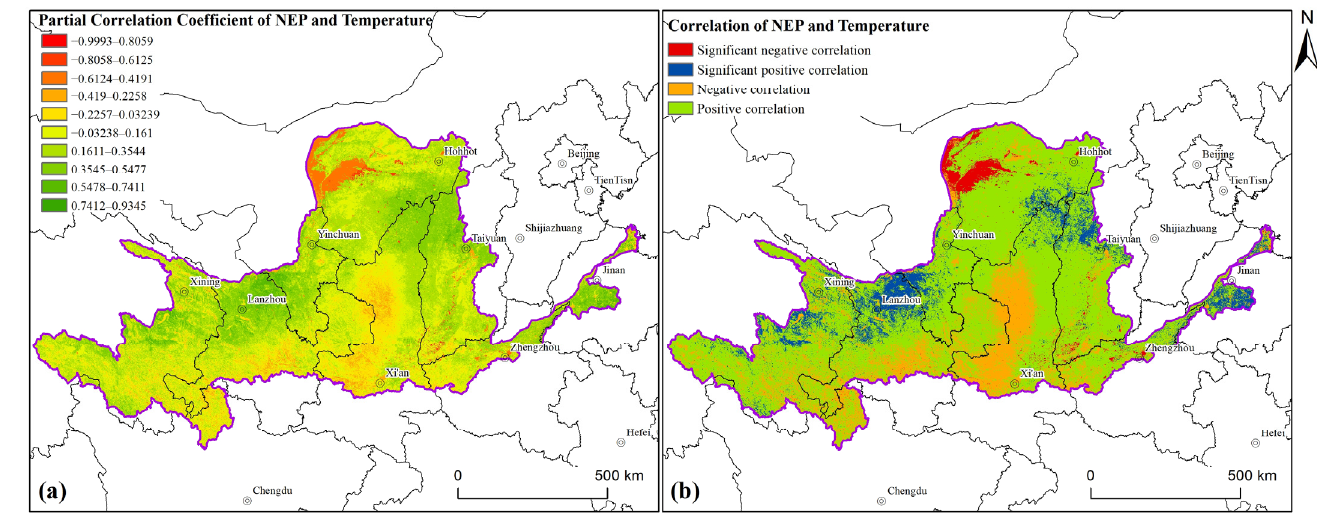
Figure 7. Partial correlation coefficient and significance test results of NEP and temperature. ( a ) The partial correlation coefficient between NEP and temperature divided into 10 categories according to equal intervals. ( b ) The grading results passing the significance (95%) test.